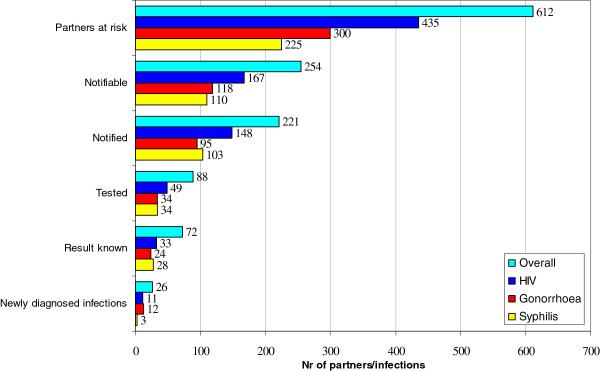
Case-finding effectiveness of PN among MSM.